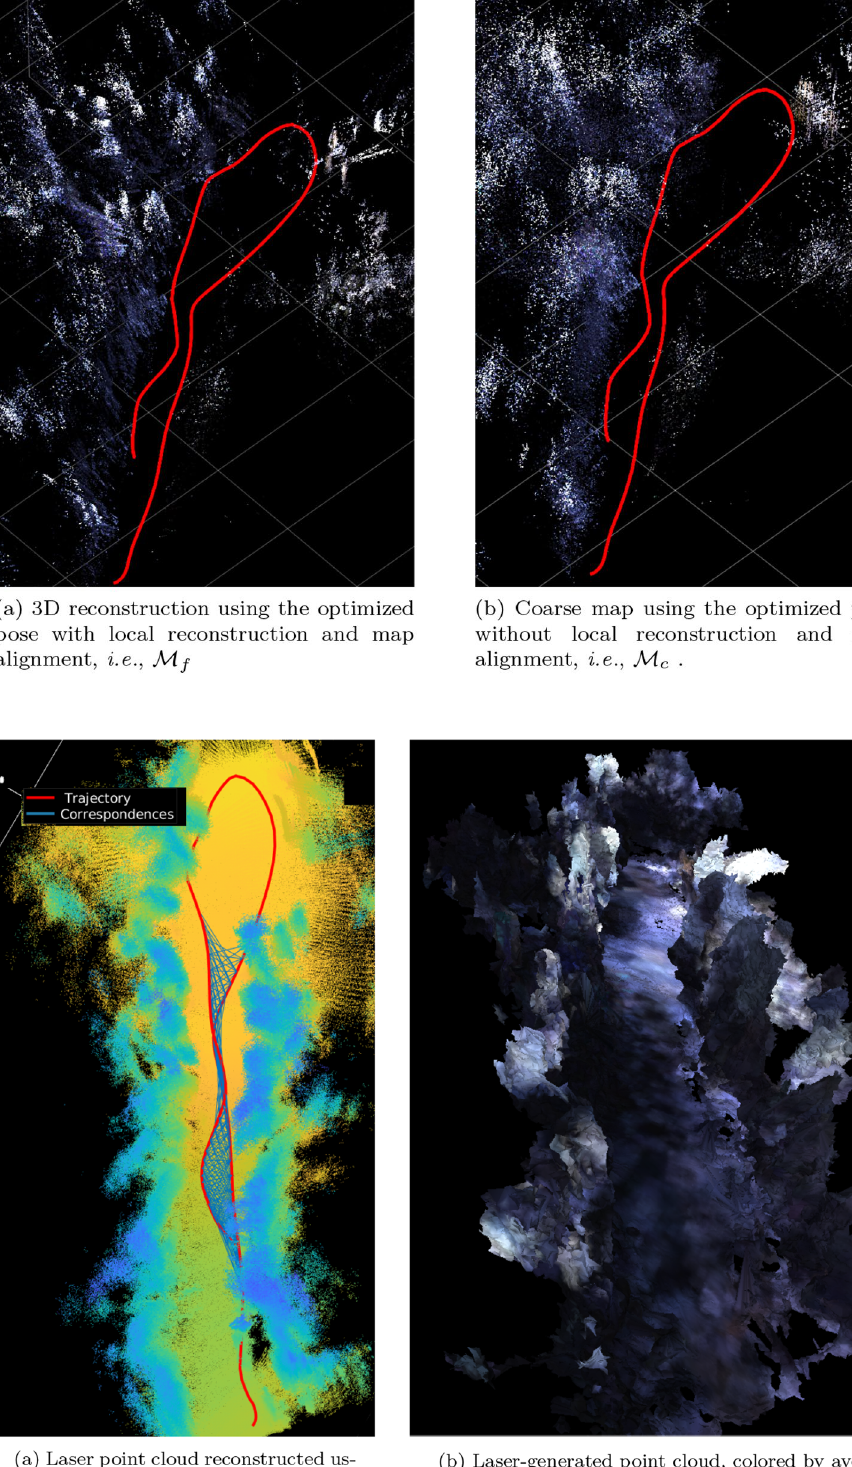
Fig. 11 Comparison of the effect of local reconstruc- tion with map alignment as discussed in Sect. 3.4.1.. The above figure shows an isomet- ric view of a scene consisting of trees and a house on the top right corner